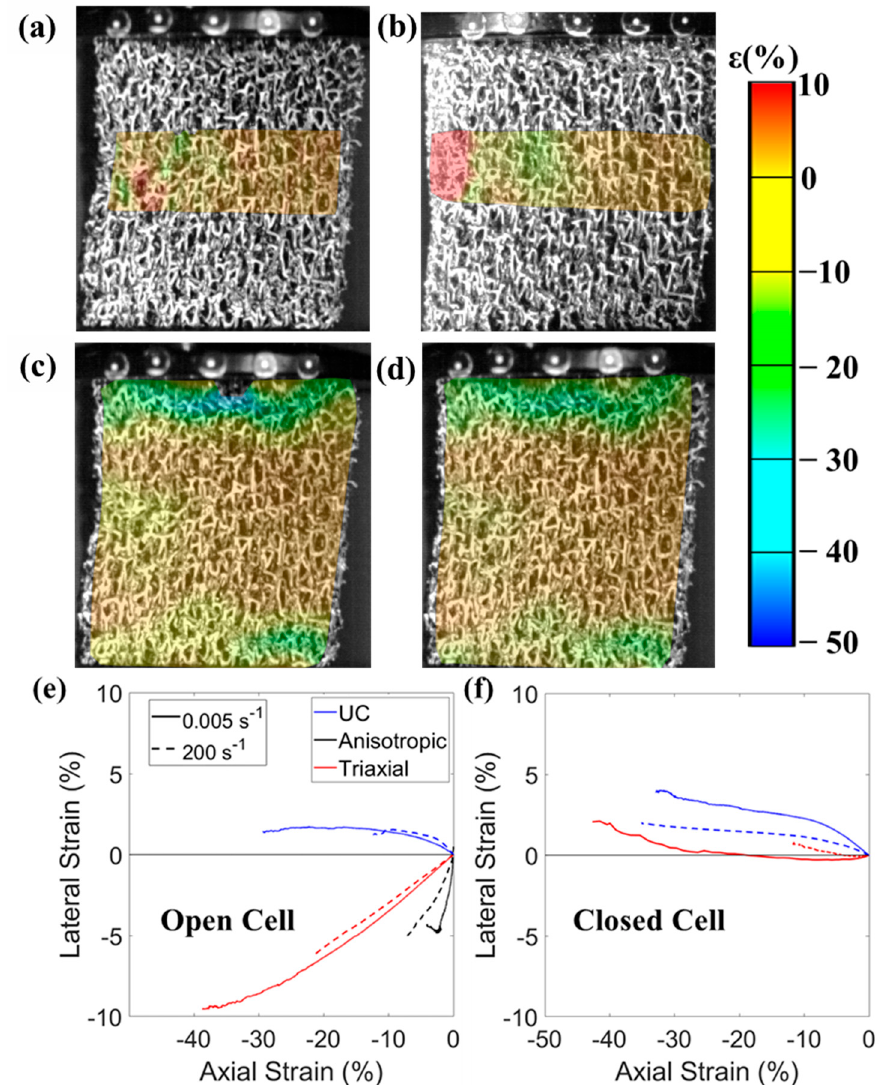
Figure 4. ( a,b ) DIC contour plots of anisotropic open cell foam showing lateral strain ( x -axis) used for Poisson’s ratio measurement at 2% compression ( y -axis) and an applied strain rate of ( a ) 0.005 s − 1 , ( b ) 200 s − 1 ; ( c,d ) DIC contour plots of anisotropic open cell foam showing axial strain ( y -axis) at 2% compression and an applied strain rate of ( c ) 0.005 s − 1 , ( d ) 200 s − 1 ; ( e,f ) Lateral vs. axial strain relationships for ( e ) open cell foams; ( f ) closed cell foams at applied strain rates of 0.005 s − 1 and 200 s − 1 . Legend (RHS) is the same for ( a ) to ( d ).